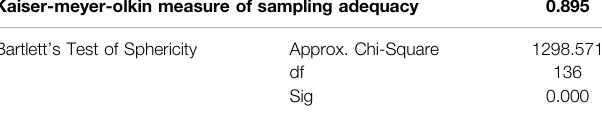
TABLE 5 | KMO and Bartlett ’ s test.